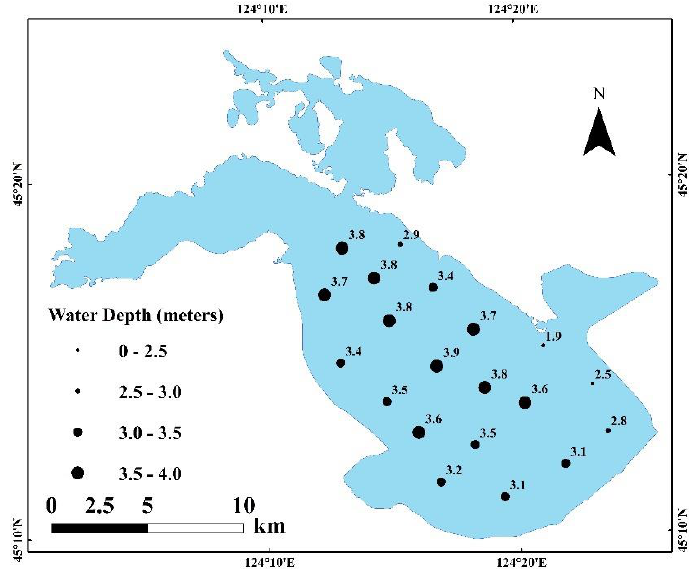
Figure 2. The water depth of Chagan Lake measured by hand-held sonar detector SpeedTech SM-5 on 17 September 2021.